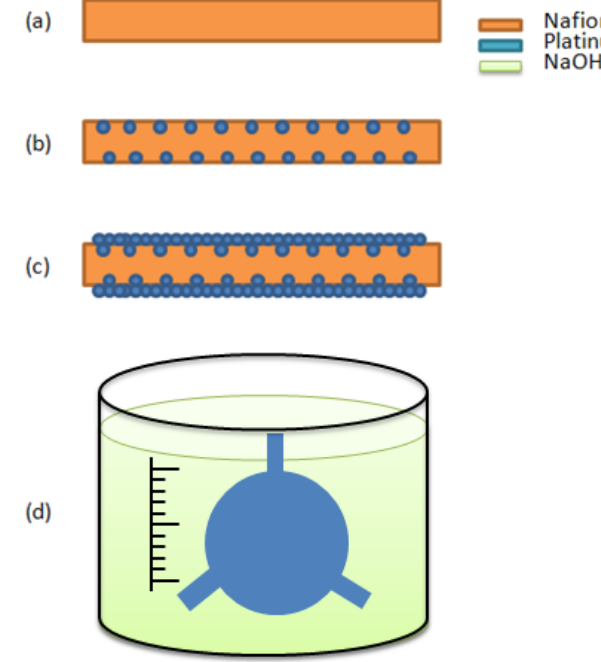
Figure 6. The IPMC process flow. ( a ) ion exchange polymer formation and pre-process; ( b ) initial compositing; ( c ) surface electrode growing; ( d ) shape cutting and immersing in the salt